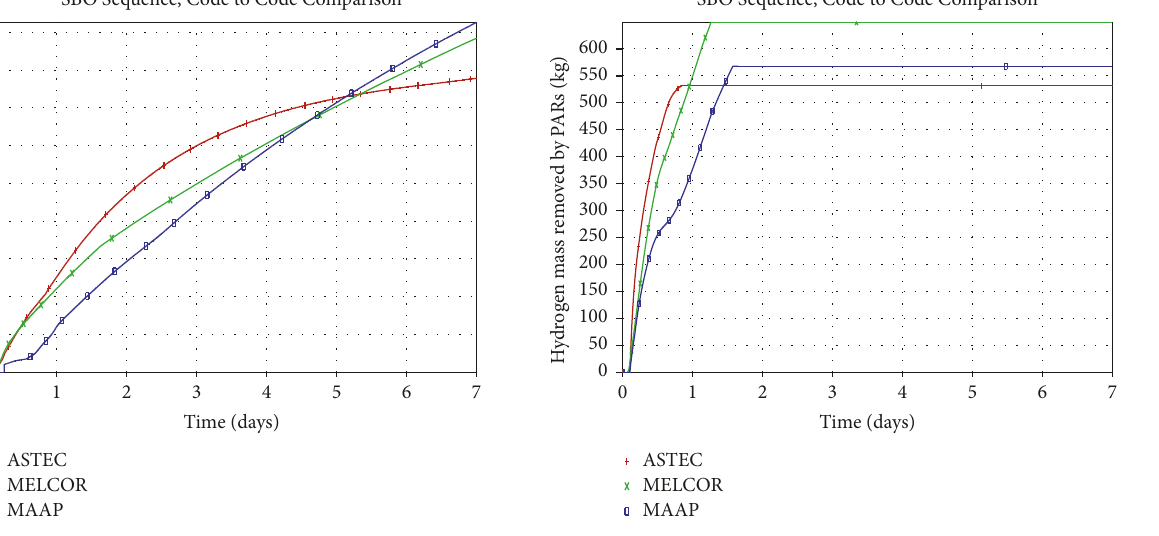
Figure 16: Mass of hydrogen removed by PAR